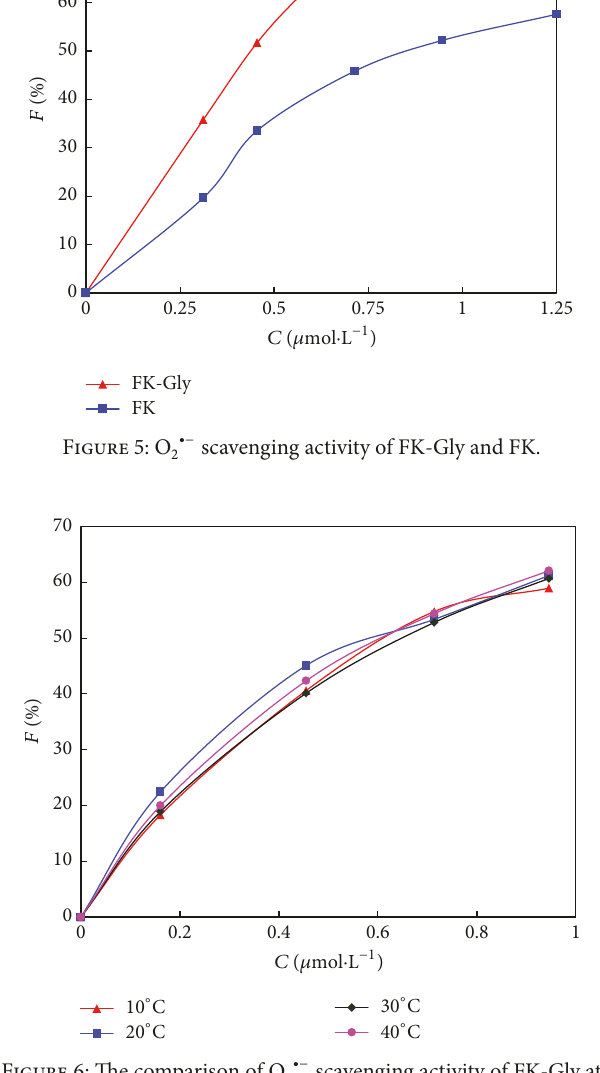
Figure 6: The comparison of O 2 ∙− scavenging activity of FK-Gly at different temperatures.